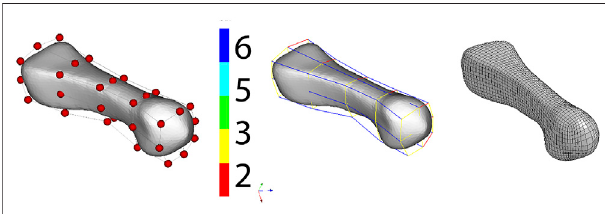
FIGURE 2 | Process of creating a hexa mesh in the IA-FEMesh software illustrated by the example of metatarsal bone.